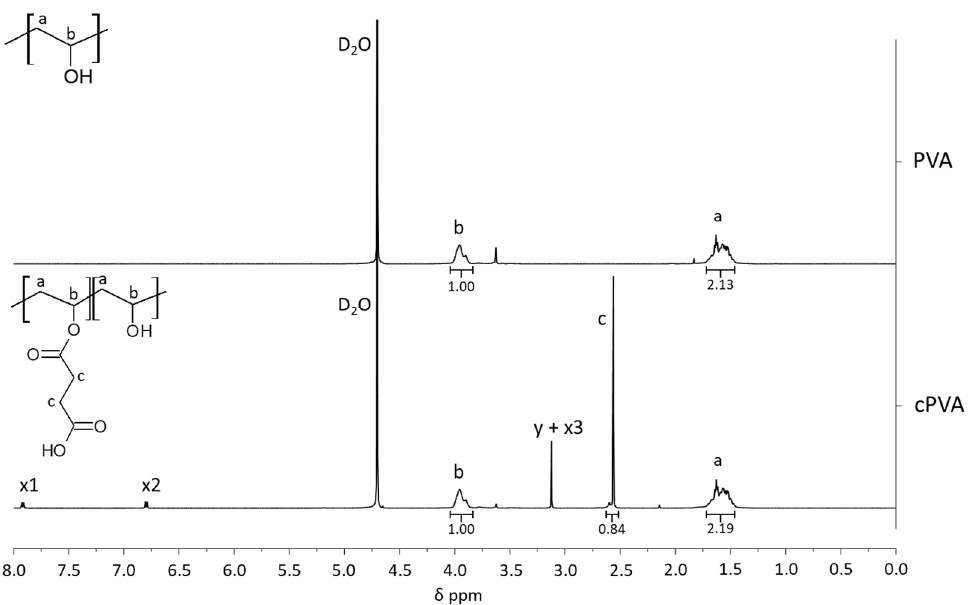
Figure 2. 1 H-NMR spectra of PVA and cPVA. Poly(vinyl alcohol) (PVA): 1 H-NMR (D 2 O, 500 MHz): a = δ 1.62 (m, 2H, CH 2 ), b = δ 3.96 (m, 1H, CH). Carboxylated poly(vinyl alcohol) (cPVA): 1 H-NMR (D 2 O, 500 MHz): a = δ 1.62 (m, 2H, CH 2 ), c = δ 2.56 (s, 4H, CH 2 CH 2 ), b = δ 3.96 (m, 1H, CH), x = 4-Dimethylaminopyridine (4-DMAP) trace peaks, y = succinic anhydride trace peaks.